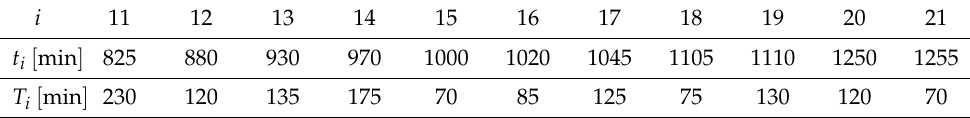
Table 7. Input values of constants t i and T i for flights 11–21.